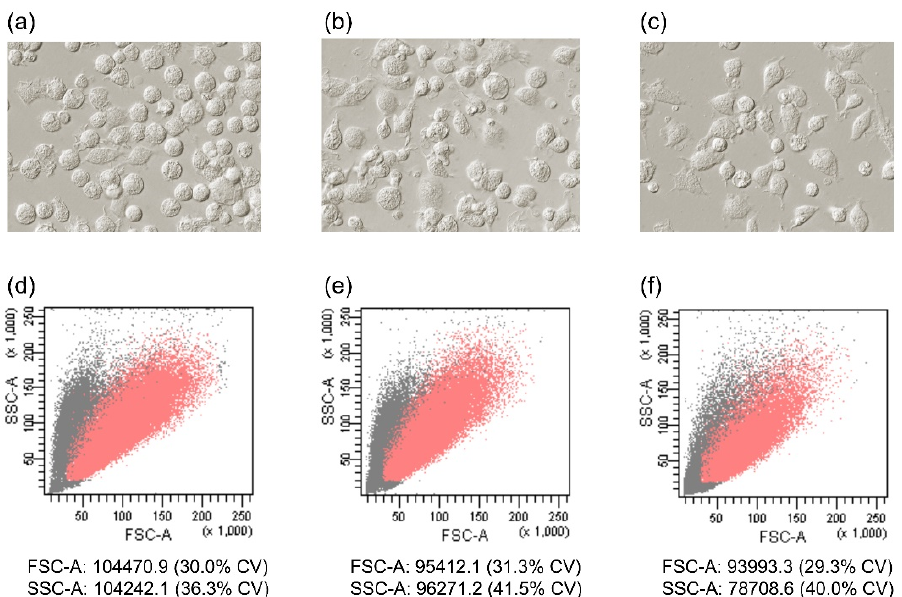
Figure 1. Morphology of monocyte-derived macrophages. Images from light microscopy with Hoffman modulation contrast ( a – c ) and FSC/SSC characteristics ( d – f ) of MDMs cultured with fetal bovine serum (FBS1, ( a , d ); FBS2, ( b , e )) or reduced-serum medium (NUS, ( c , f )) are shown with corresponding dot plots (all single cells–gray color, live cells (propidium iodide negative)–red color). Images are representative of at least four pigs. Mean values for FSC-A and SSC-A are marked under each dot plot, including the coefficient of variation (CV). Data represent the mean of 18 MDM cultures for each supplementation.